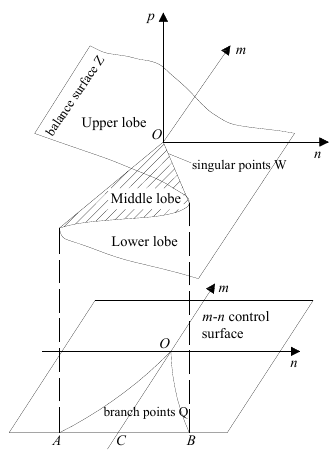
Figure 4. Balance surface Z and bifurcation set.